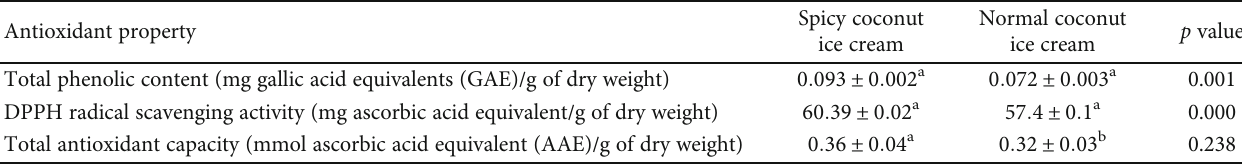
Table 3: Comparison of antioxidant activities of spicy coconut ice cream with normal coconut ice cream.